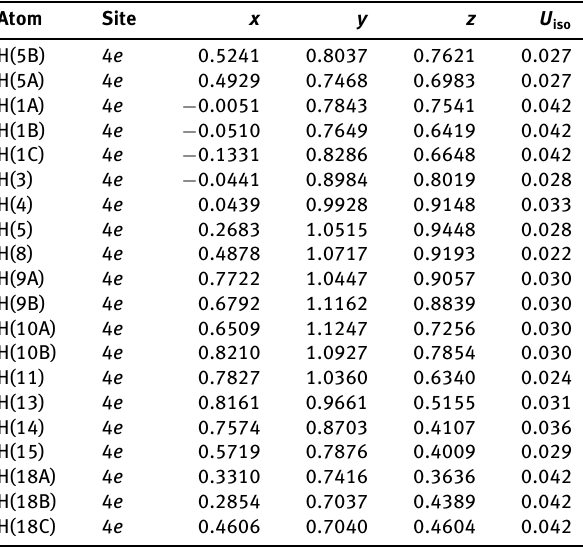
Table 2: Fractional atomic coordinates and isotropic or equivalent isotropic displacement parameters (Å 2 ).